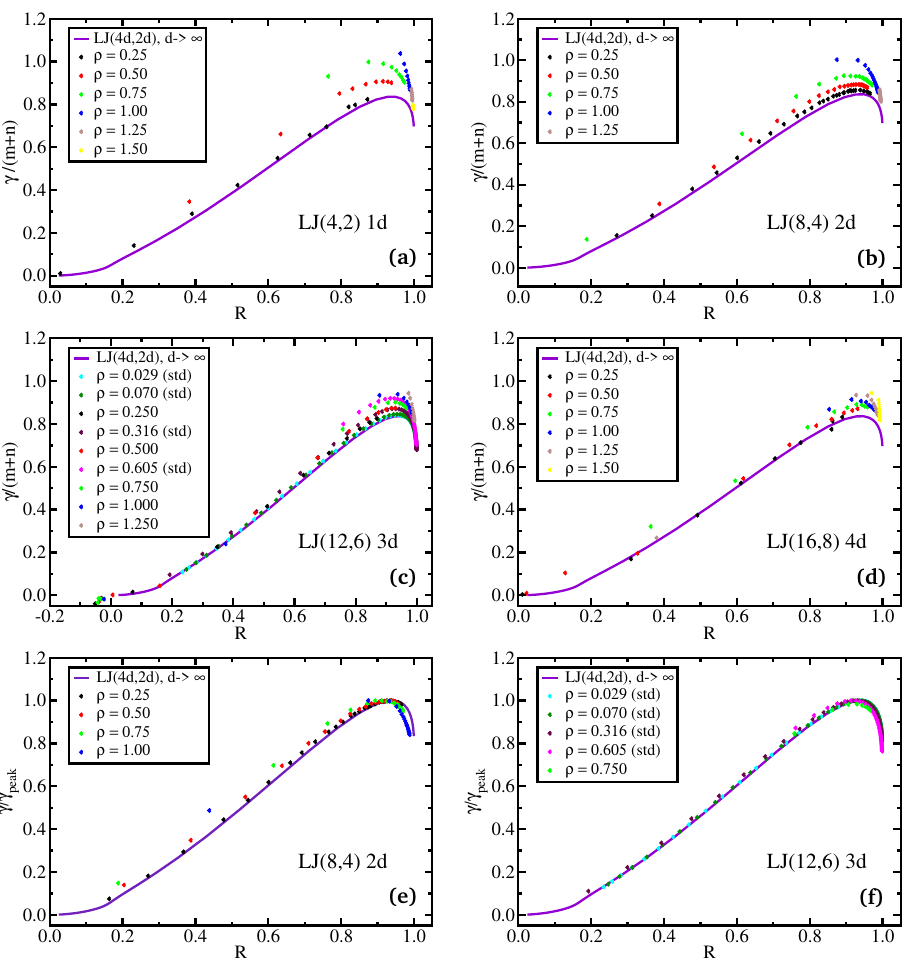
Figure 3: ( R , γ ) diagrams for the LJ ( 4 d ,2 d ) potential for d = 1,2,3,4. The density range is given in the inset while the temperature varies from T = 0.5 → 5 in 0.5 steps (except when otherwise stated). The virial approximation curve Eq. (13) for ( r ) . n = X = 2 is represented by the full violet curve. (a) d = 1, the potential is v 4,2 ( r ) . Here the temperature steps are 0.25 starting (b) d = 2, the potential is v 8,4 from T = 0.25. For ρ = 0.25 and ρ = 0.50, the highest temperature simulated is T = 12.00 and T = 7.00, respectively. This ensures visibility of the peak in γ ( R ) in ( r ) . Data for both the standard panels (e) and (f). (c) d = 3, the potential is v 12,6 12-6 LJ (labelled "std") and the generalized LJ(12,6) are presented. The unit length for these two potentials is different, resulting in different definitions for the density. The lowest temperature on each isochore is either along the liquid-gas or liquid- solid coexistence curves for the standard LJ; for the generalized LJ(12,6) densities and temperatures are the same as in (a) with the addition of T = 0.25,0.75. The